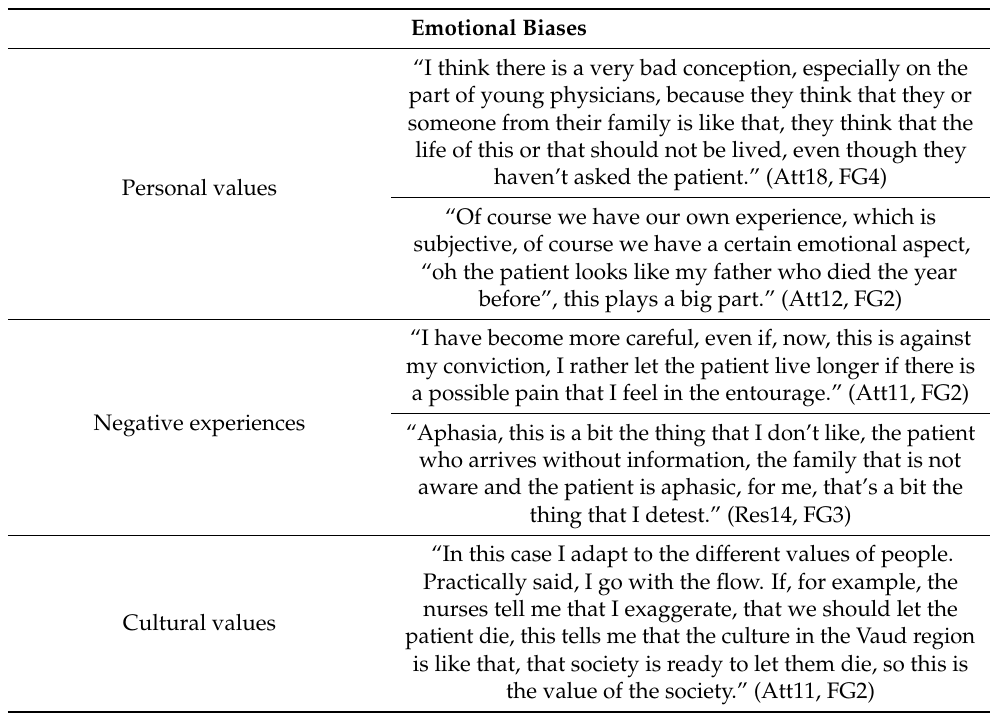
Table 4. Emotional